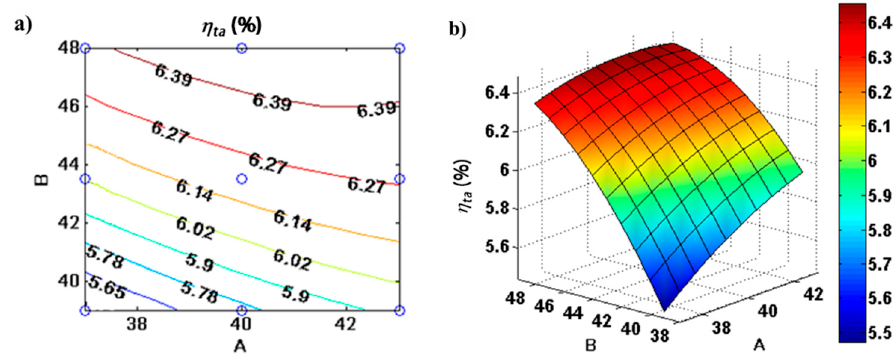
Figure 9. Contour plot ( a ) and 3D-response surface ( b ) of thermoacoustic e ffi ciency η ta at “Junction”, against the combined e ff ect of operating frequency and compliance inner diameter A and B, respectively.